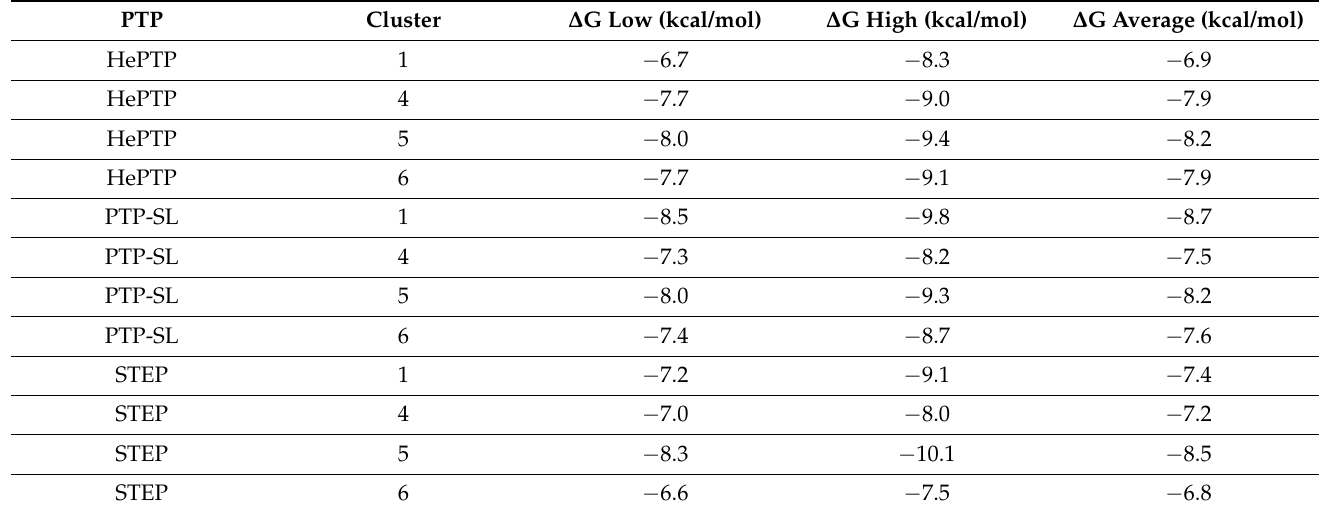
Table 2. Binding affinities ( ∆ G) of the top 500 binders from targeted docking of the Chembridge Diverset library at the pockets associated with clusters 1, 4, 5 and 6 for HePTP, PTPSL and STEP.